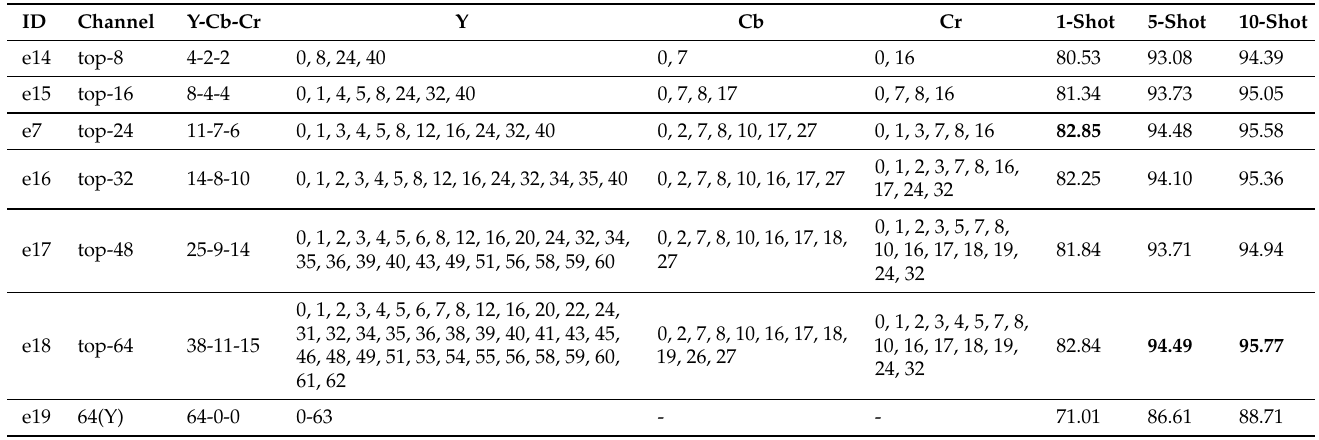
Table 3. The results of different top-N frequencies selected from full 192 channels. ( f θ :